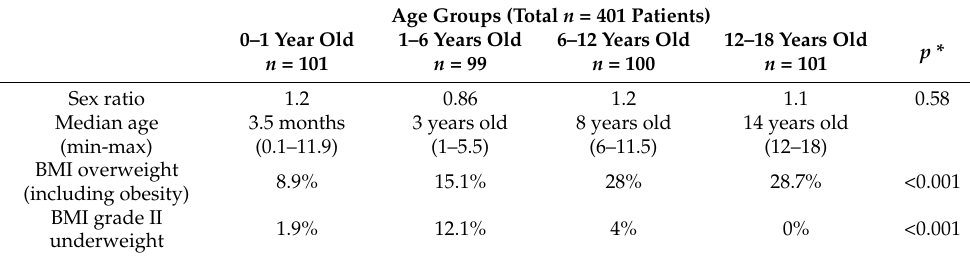
Table 1. Demographic data and BMI data of the pediatric population, by age group.